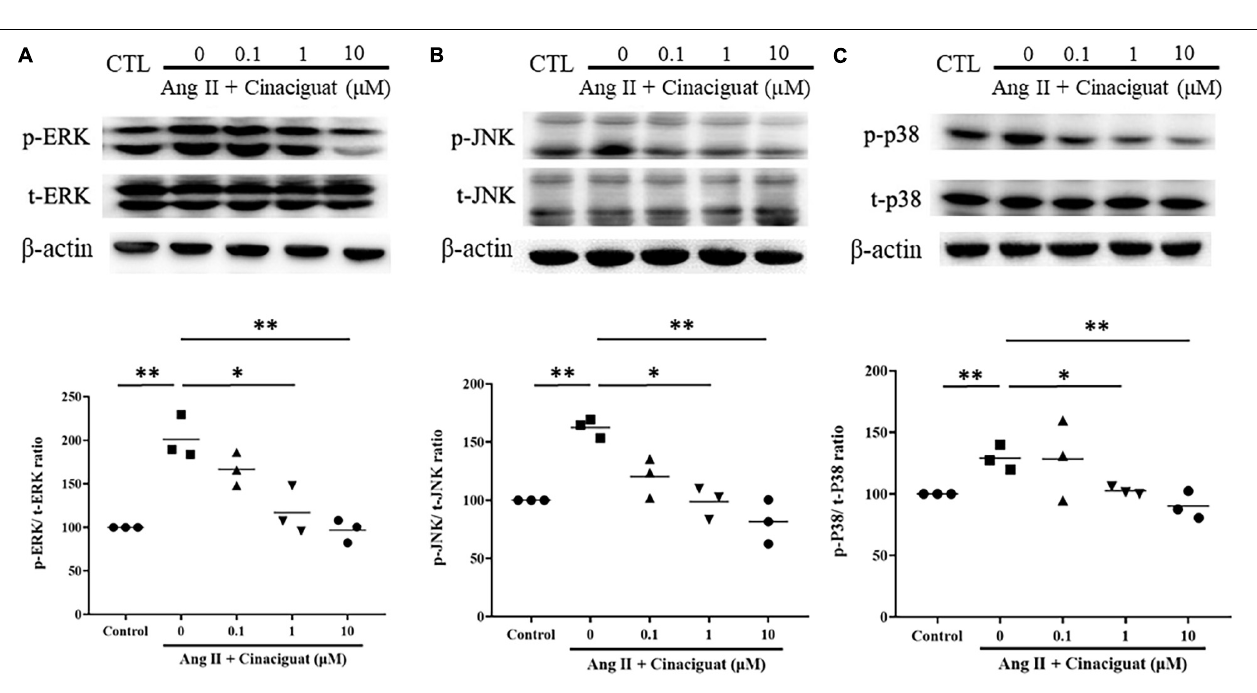
FIGURE 7 | Effects of cinaciguat on Ang II-induced activations of MAPKs pathways presented by Western blotting. Western blotting shows that cinaciguat-attenuated Ang II-induced phosphorylation of (A) ERK 1/2, (B) JNK, and (C) p38. Values are presented by the dot plot with the mean. N = 3. All one-way ANOVA P < 0.0001. * P < 0.05 and ** P < 0.01 vs. Ang II